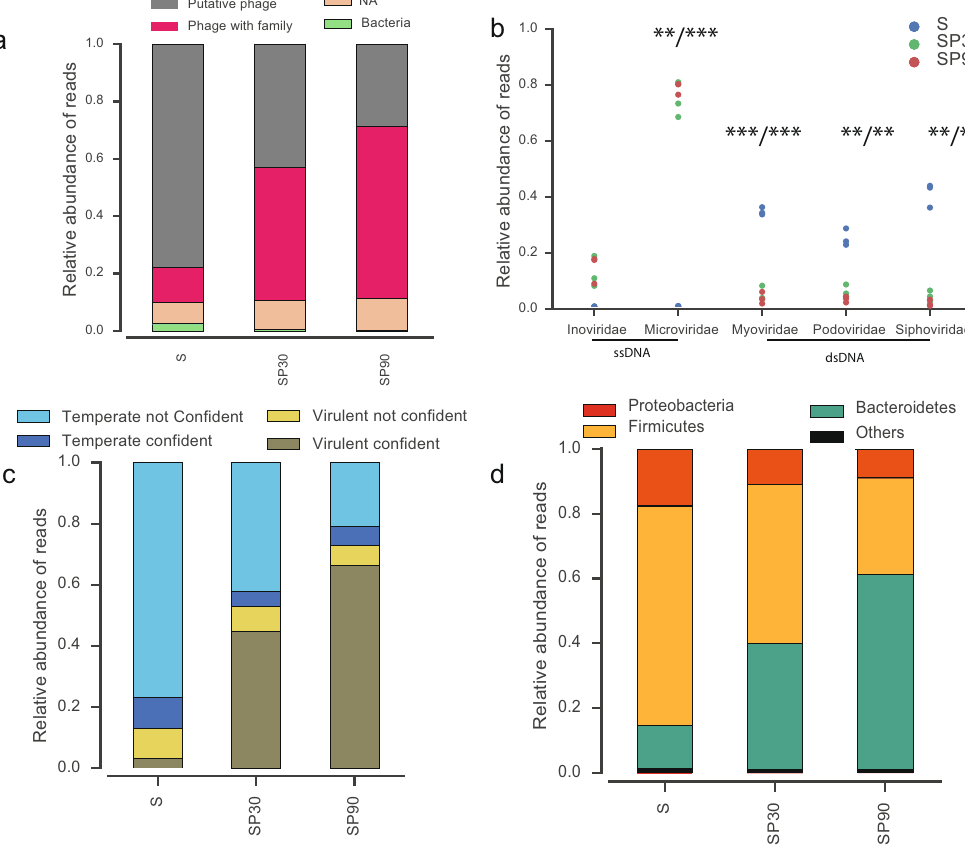
Figure 5. Analysis of the contigs of the healthy volunteers’ (AA, BB, CC) samples. ( a ) Bar plots of the relative abundance of reads for each contigs category in each method: method IV for phage isolation following with a 30 min multiple displacement amplification MDA (SP30), 90 min MDA (SP90) or no MDA (S). ( b ) Plot of the relative abundance of reads for each phage family. For Microviridae, Myoviridae and Siphoviridae the relative abundance of reads are significantly different between MDA protocoles (SP30, SP90) and no MDA protocoles (S), as assessed by paired t-tests ( * < 0.05, ** < 0.01, *** < 0.001). ( c ) Bar plots of the relative abundance of the reads mapping the contigs of a certain lifestyle. ( d ) Bar plots of the relative abundance of the reads mapping the contigs of a certain host phyla. NA: